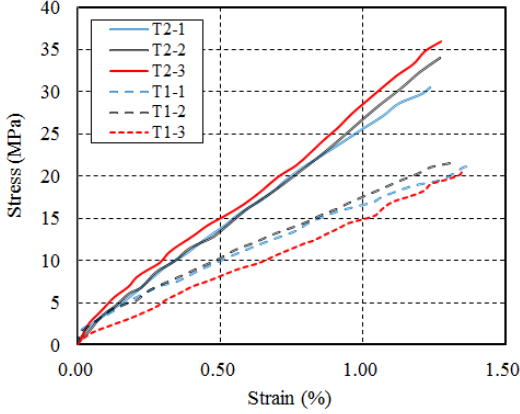
Figure 5. Stress–strain curves of FRP grid-reinforced UHPC dumbbells.